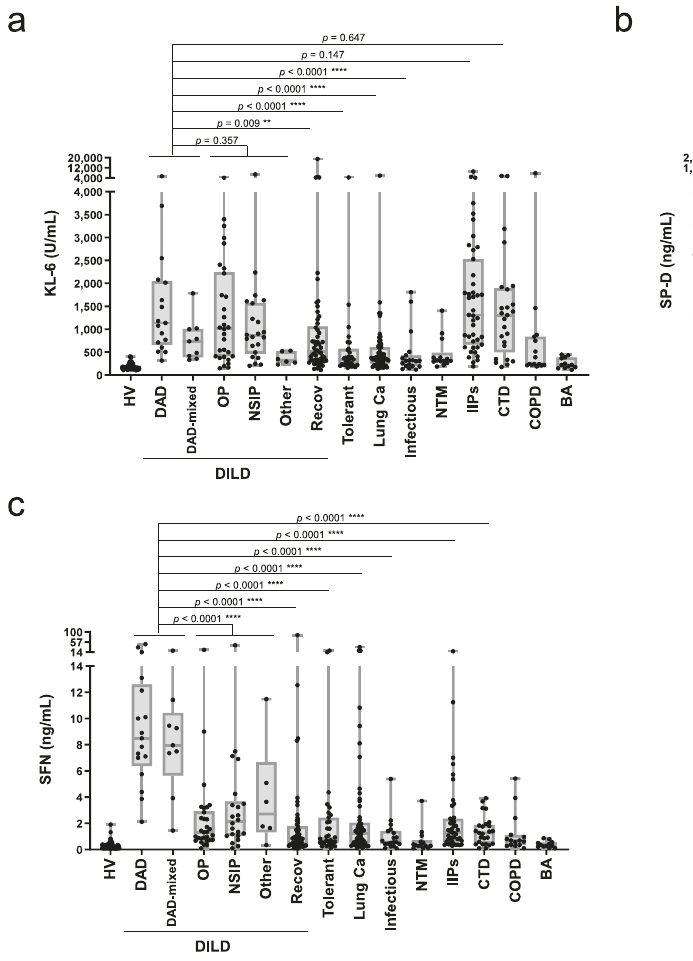
Fig. 2 | Distribution of SFN and known biomarkers in healthy volunteers and patients with various lung diseases. Results for the Combined cohort are shown. Serum levels of KL-6 ( a ), SP-D ( b ), and SFN ( c ) were measured by ELISA. Numbers of samples: HV ( n =77), DAD ( n =17), DAD-mixed ( n =9), OP ( n =30), NSIP ( n =22), Other ( n =6), Recov ( n =54), Tolerant ( n =31), Lung Ca ( n =58), Infectious ( n =19), NTM ( n =14), IIPs ( n =43), CTD ( n =25), COPD ( n =15) and BA ( n =12). The boxes indicate interquartile ranges (75% and 25%) and medians; whiskers show min and max values. Differences between the two groups were compared by a two-tailed Mann – Whitney U -test (unadjusted): ** p <0.01;